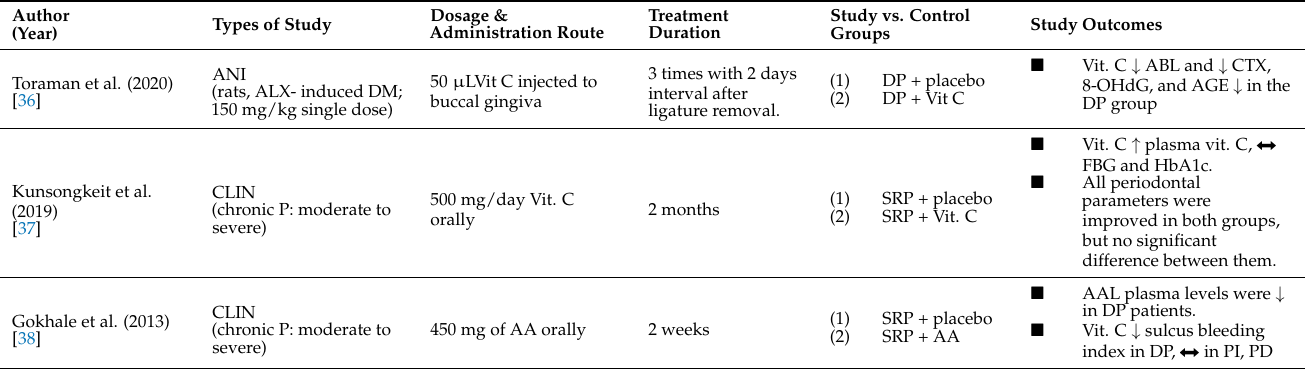
Table 6. Studies on the use of vitamin C (Vit. C) in diabetes-associated periodontitis (DP).